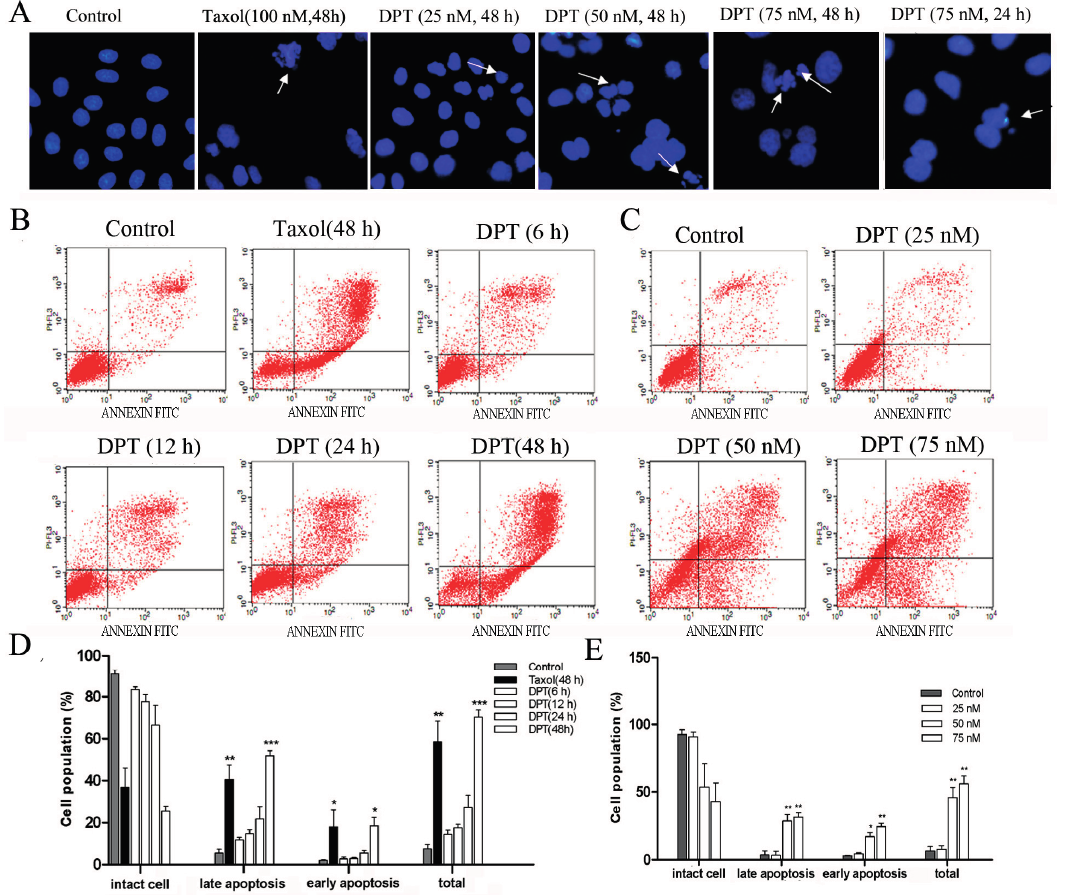
Figure 3. DPT induced apoptosis in gastric cancer cells. Cells were treated with different concentrations of DPT or taxol (100 nM) for the indicated time periods. ( A ) After DPT treatment, DNA was stained with Hoechst 33342 and observed under a fl uorescence microscope (Magnification: 200×). Arrows indicate nuclear fragmentation in apoptotic cells. ( B ) Annexin V-FITC/PI double-staining assay showed the percentage of apoptotic cells after treatment with 75 nM of DPT or 100 nM of taxol for the indicated time and ( C ) after treatment with different concentrations of DPT for 48 h. ( D , E ) Statistical analysis of the number of apoptotic cells. Data are presented as means ± SD of three independent tests. * p < 0.05 versus control, ** p < 0.01 versus control, *** p < 0.001 versus